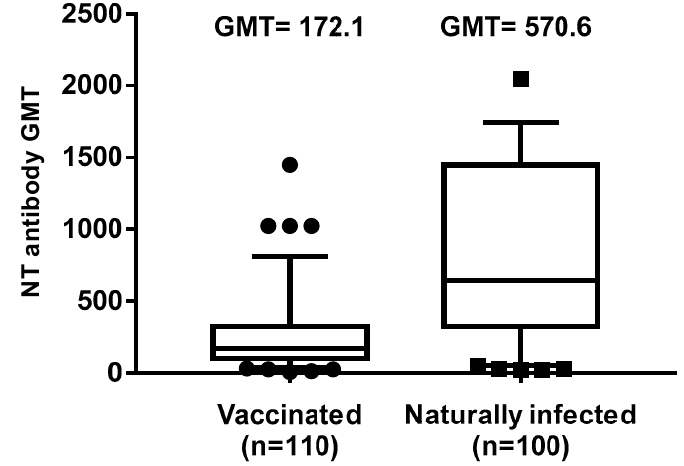
Figure 4. Differences in neutralizing antibody titers between subjects vaccinated with two doses of measles vaccine and naturally infected subjects are shown. The whiskers represent the values from the 5th to the 95th percentiles; the median, the 25th and 75th percentiles are depicted by the horizontal lines in the boxes. Individual data points are shown; outlier values are shown as black circles or squares. GMTs are shown above the population columns. p -value of the GMT between the two groups is ≤ 0.00001.